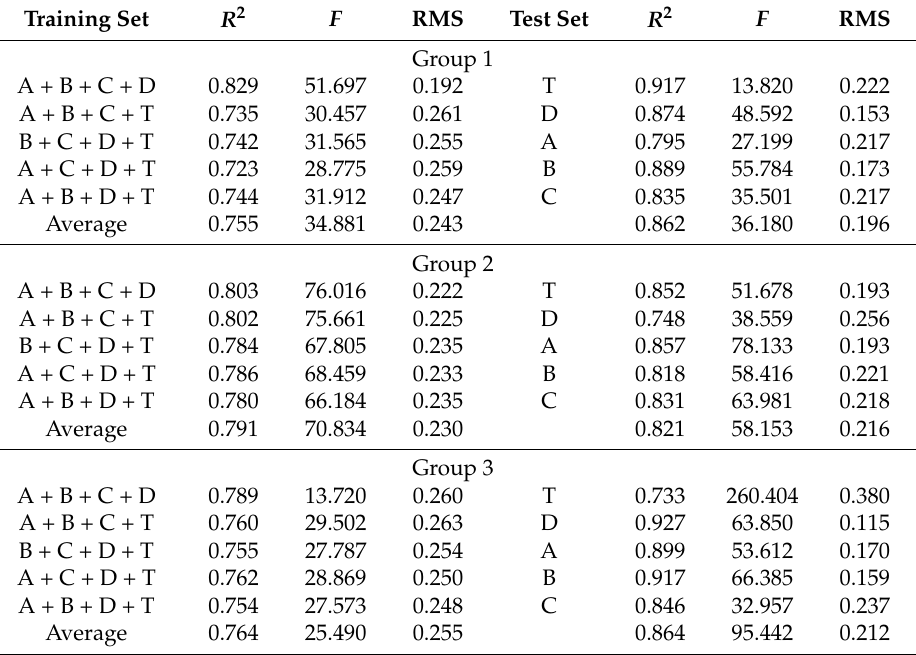
Table 6. Validation of the MLR